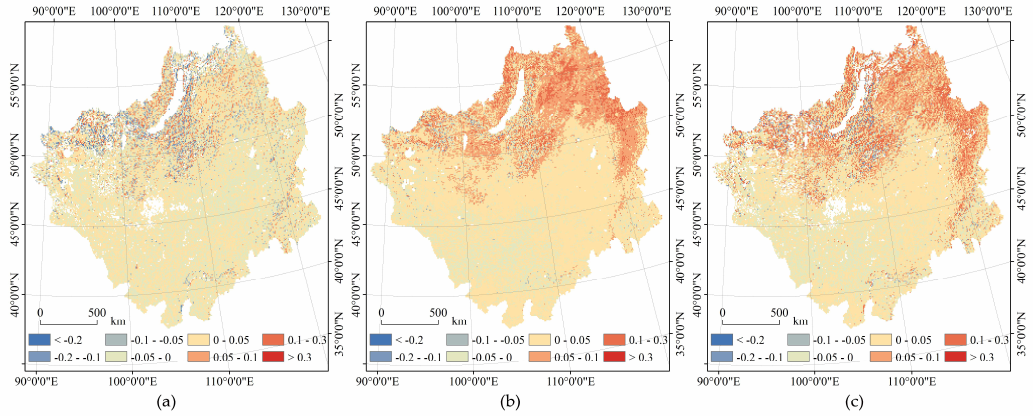
Figure 5. Spatial distribution of the mean bias error (MBE) between ( a ) GIMMS3g NDVI and MOD13A3 NDVI, ( b ) GIMMS3g NDVI and SPOT-VGT NDVI, and ( c ) MOD13A3 NDVI and SPOT-VGT NDVI.